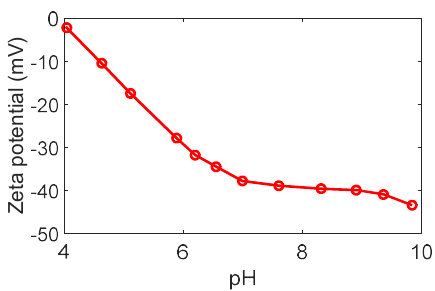
Figure 4. Zeta potential of the PVDF membrane surface.